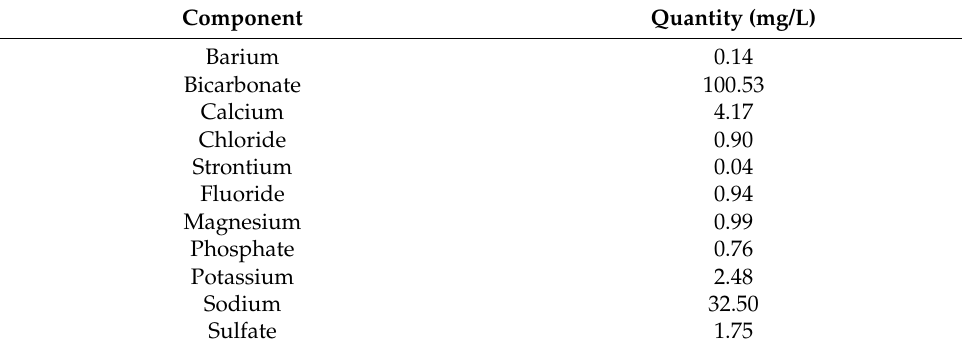
Table 1. Physico-chemical characteristics of the used mineral water.